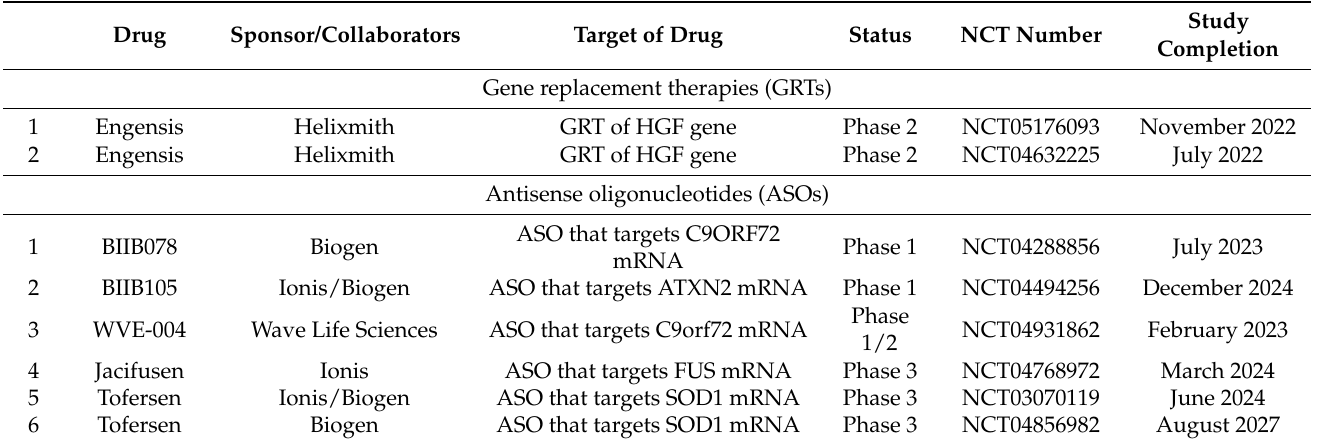
Table 1. Gene-specific therapies for ALS tested in clinical